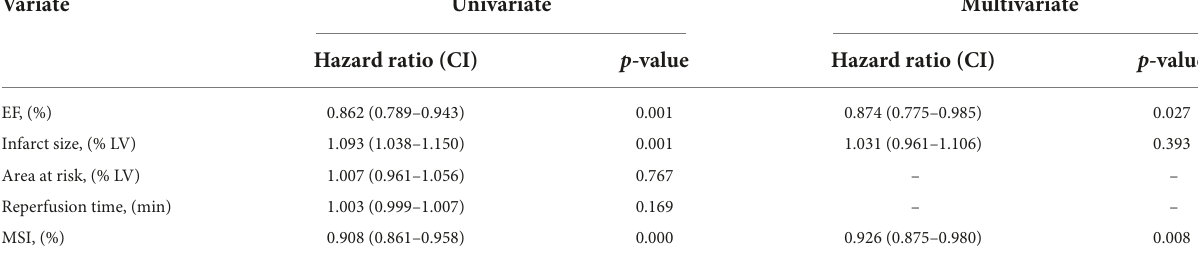
TABLE 3 Univariate and stepwise multivariate cox regression analysis for the prediction of MACEs. Variate Univariate Multivariate Hazard ratio